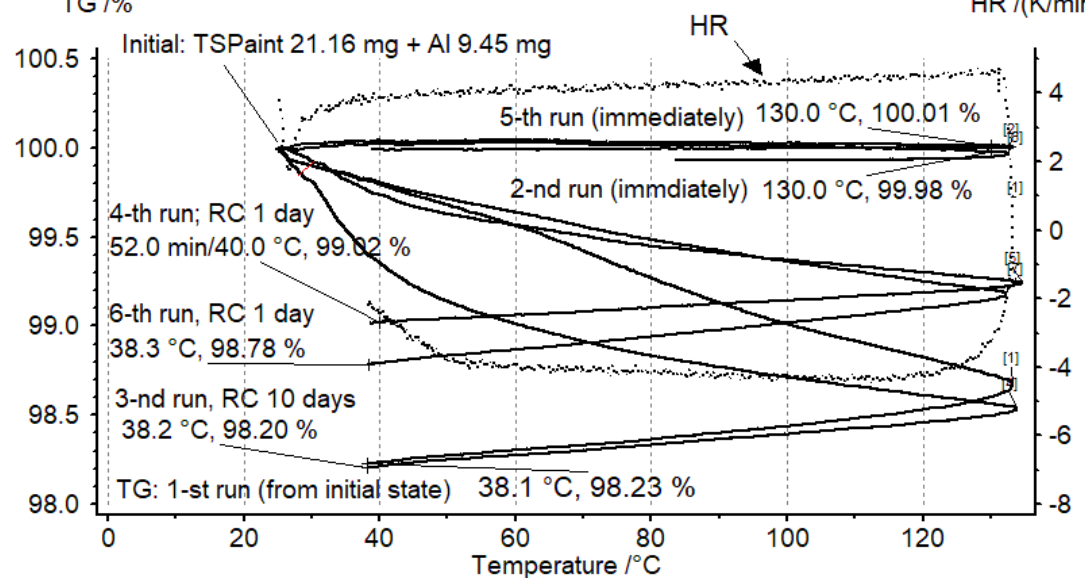
Figure 4. Results of thermogravimetric (TG) investigation of TSP deposited by aerosol spraying on aluminum foil sub- strate.